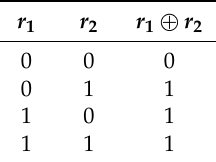
Table 1. Results for stacking two different pixels